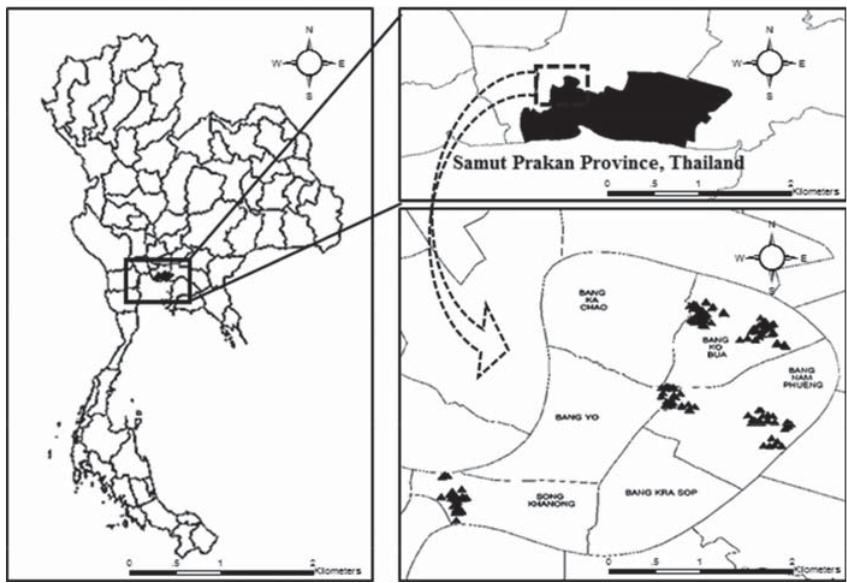
Figure 1. Location of studied households (black triangles) in